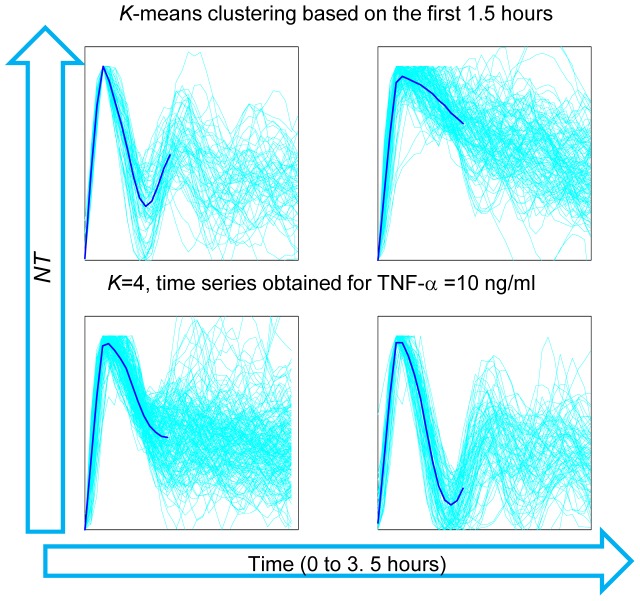
Clustering analysis of the short-term dynamics of NF-κB.Clustering of the NT traces for the first 1.5 hours of cells exposed to 10 ng/ml TNF-α, using a K-means algorithm. The individual traces (450) are in cyan and the centroids of the cluster are plotted in blue.